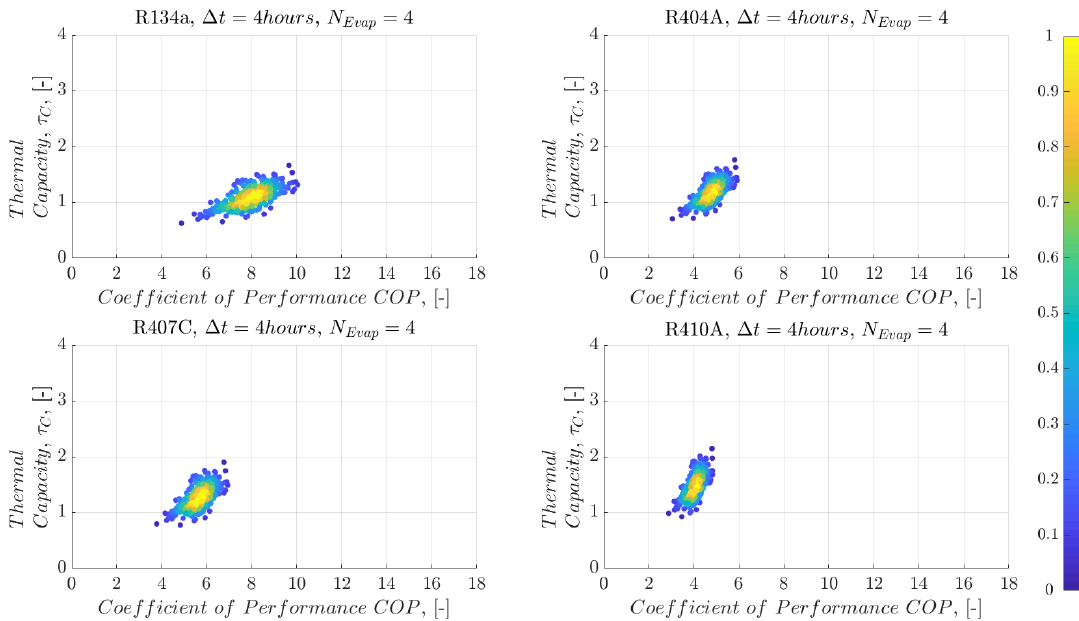
Figure17. Probabilitydensityestimationoftherelativee ffi Figure 17. Probability density estimation of the relative efficiencies for all refrigerants and four collectors.